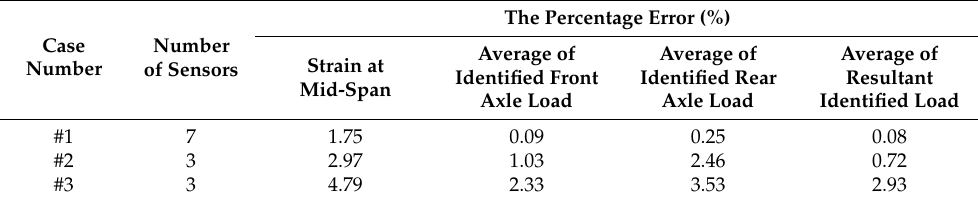
Table 11. The percentage error for different sensor